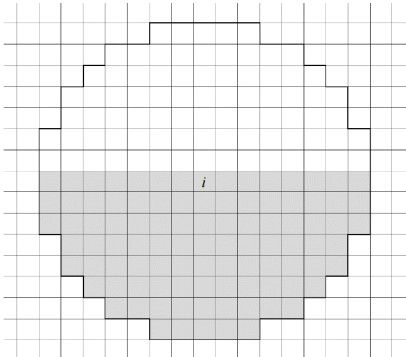
Figure 7. Template disk for evaluation of boundary curvature.